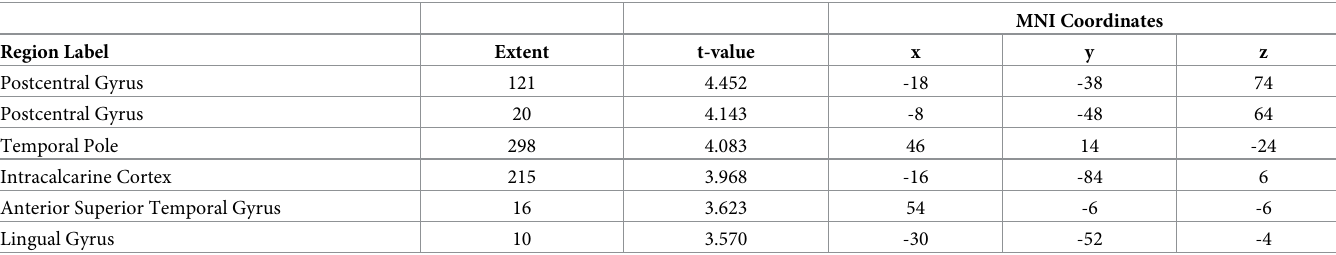
MNI Coordinates